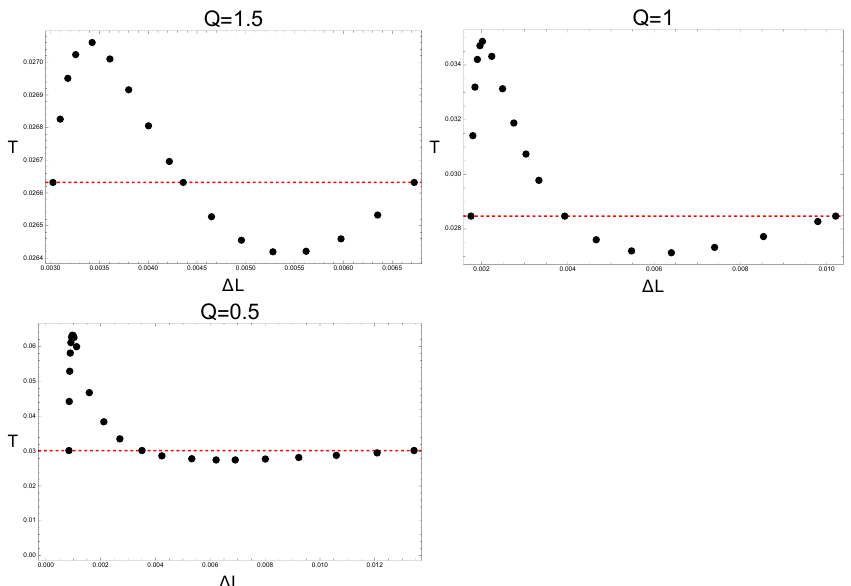
Figure 5 . Charge dependence of T (cid:0) (cid:1) L diagrams. The plots are displayed for the d = 4 charged ADS black holes. The phase transition temperature T (cid:3) is plotted in red in each case. Again we have l = 10, (cid:18) 0 = 0 : 15, and (cid:18) c = 0 :